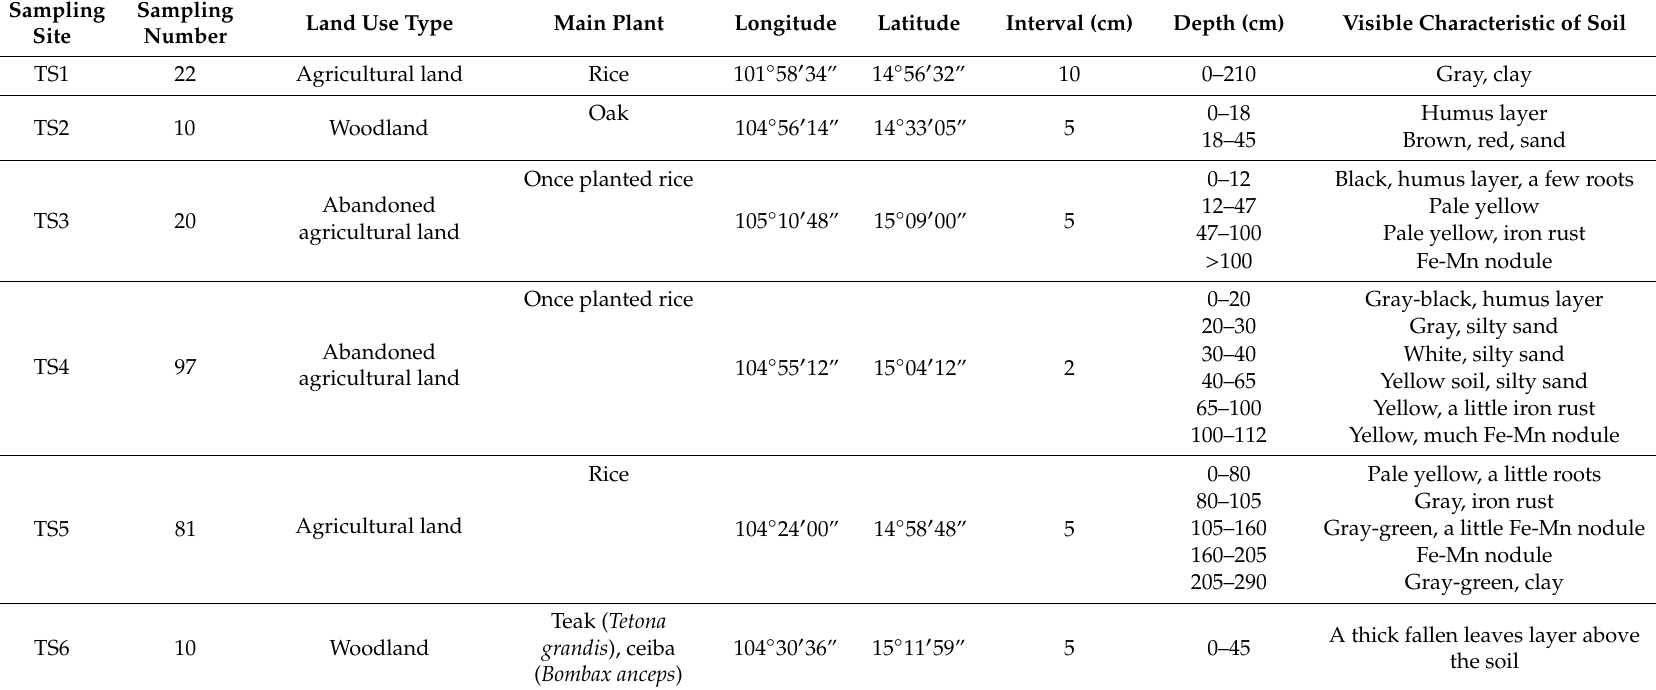
Table 1. The information on the sampling